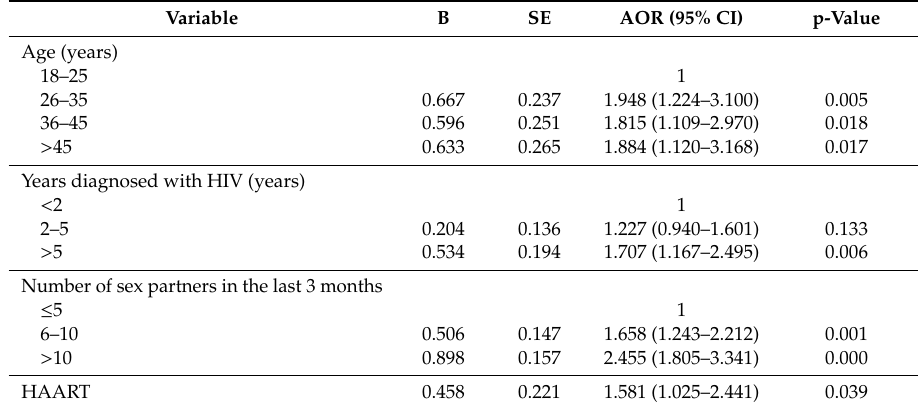
Multivariate logistic regression analyses of the risk factors associated with active syphilis